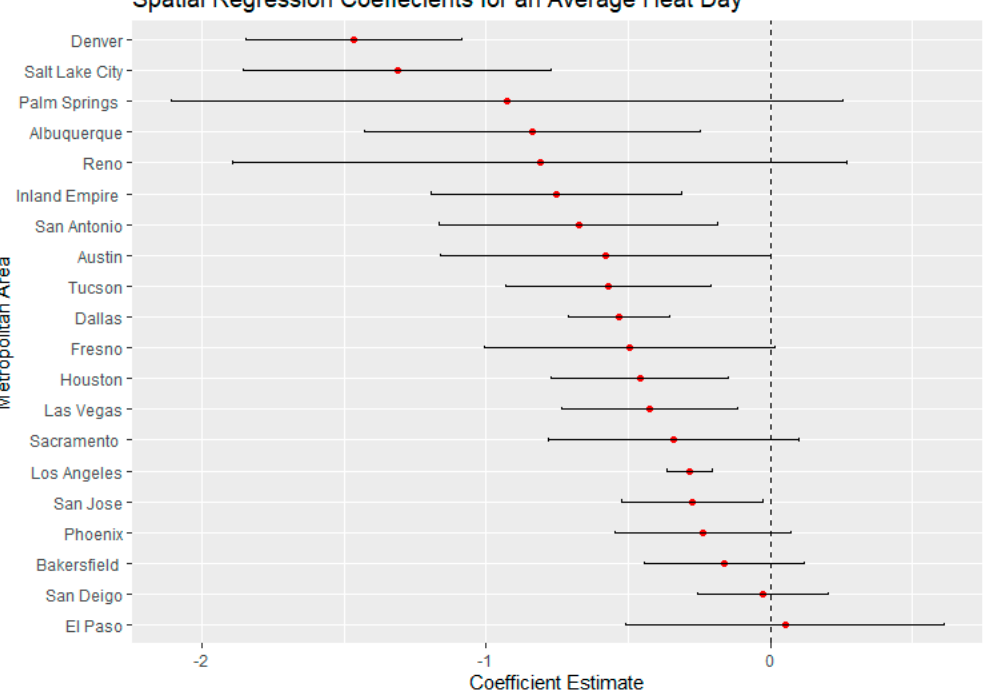
Figure 5. Spatial regression coefficients for median income during an average heat day in 20 Southwest metropolitan areas.